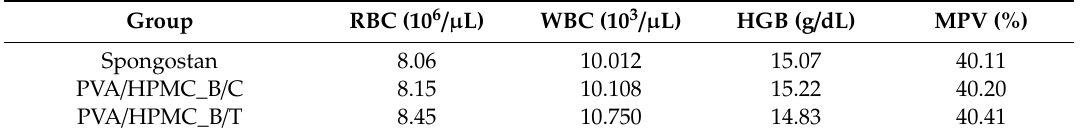
Table 4. The results of the blood morphological analyses after the application of Spongostan, placebo